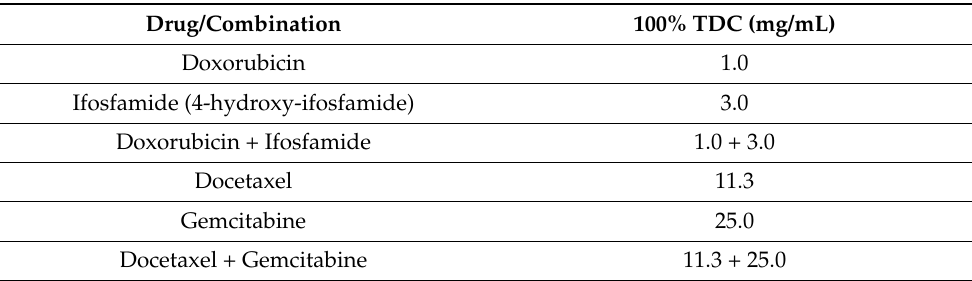
Table 1. Drugs tested and their 100% TDC as used in